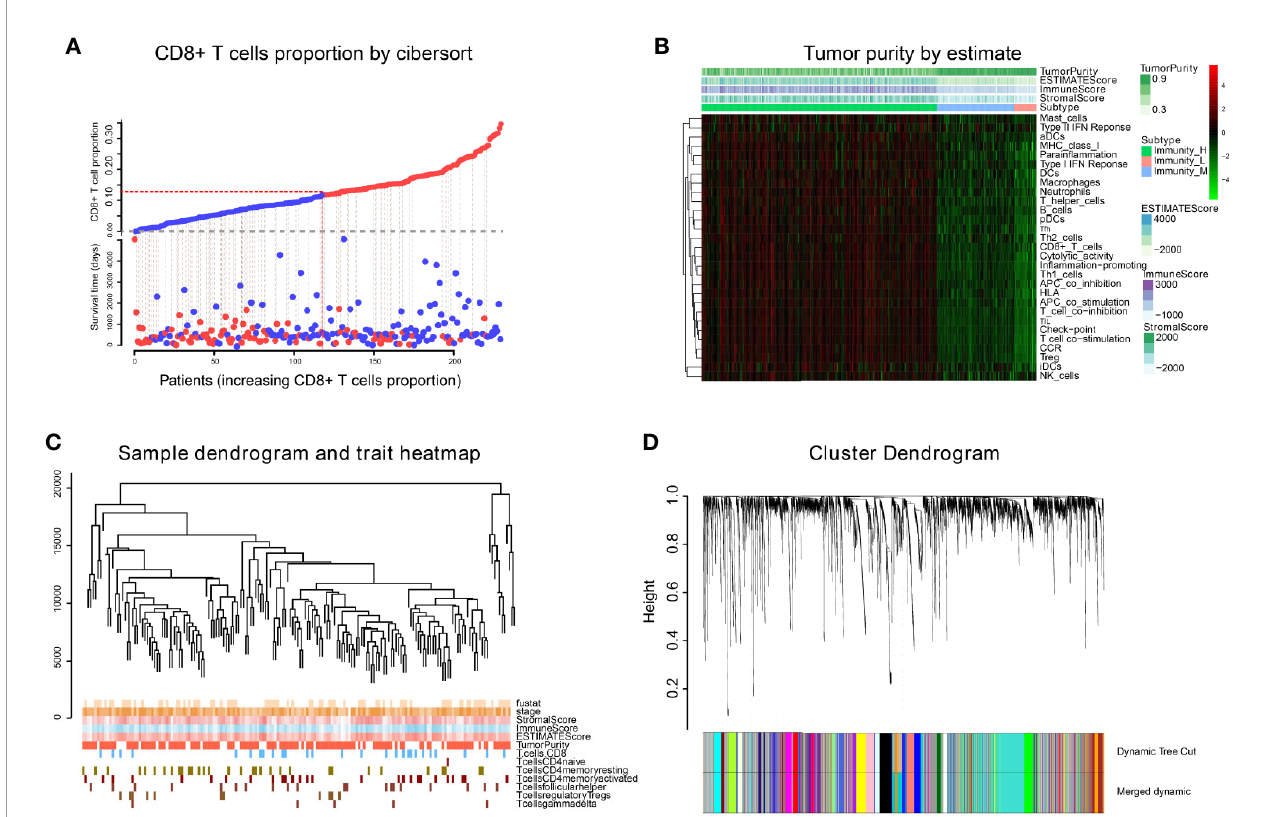
FIGURE 2 | WGCNA analysis. (A) The in fi ltration proportion of CD8+ T cells in TCGA. (B) The immune score, estimate score, stromal score, and tumor purity of TCGA-BLCA are shown, and were inputted as phenotype information for WGCNA analysis. (C) We clustered the samples by cut Height = 20,000, and 226 samples were included. The sample dendrogram of 226 samples and trait map are shown. (D) Hierarchical clustering tree was built using the dynamic hybrid cutting method, where each leaf on the tree represents a gene, and each branch represents a co-expression module; 28 co-expression models were